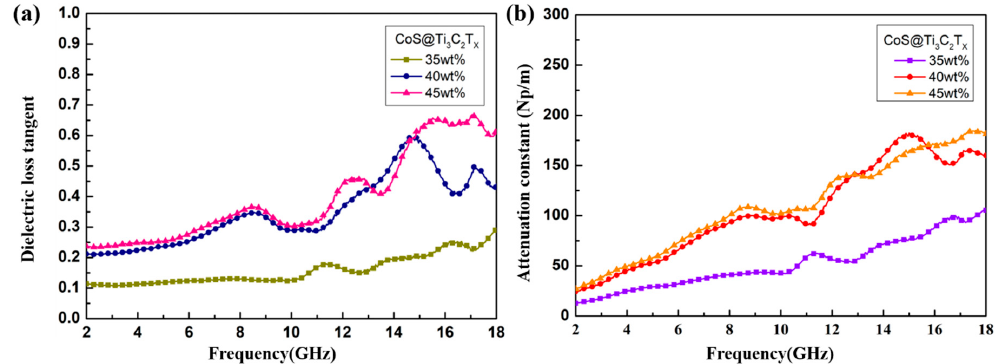
Figure 8. Dielectric loss tangent ( a ) and attenuation constant ( b ) of CoS@Ti 3 C 2 T x composites with different filler loadings.